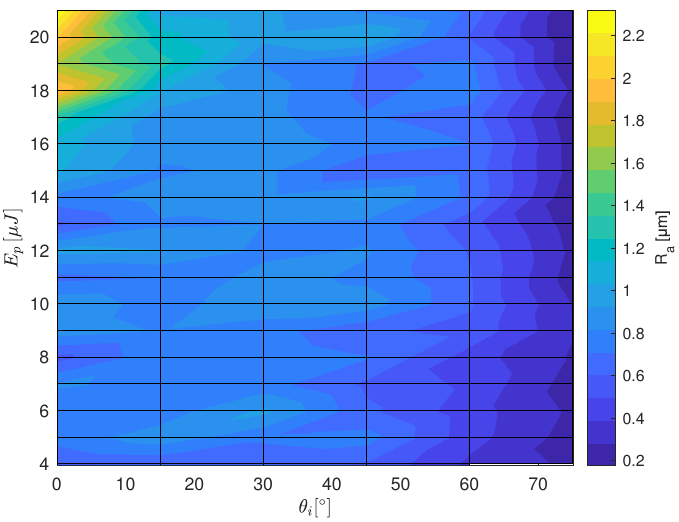
Figure 7. Ra values measured on the ATZ ceramic HTZ 500 LC for the range of pulse energies and the tilt angles from the calibration experiment (see Figure 2). The white area indicates where no ablation was observed.